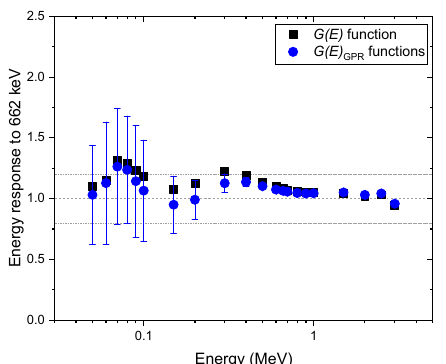
Figure 8. Comparison of energy response normalized to the energy of 622 keV, estimated with G ( E ) functions, and the G ( E ) function for the spectra obtained under the angle of incidence of 90 ° . The error bar shows a 95% confidence interval.